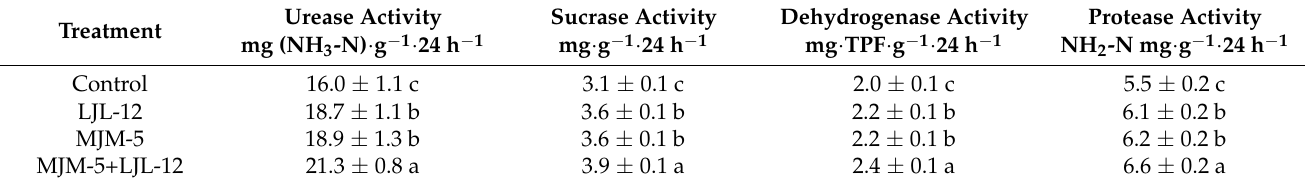
Table 3. Urease, sucrase, dehydrogenase, and protease activities of the alfalfa rhizosphere soil under Control, LJL-12, MJM-5, and MJM-5+LJL-12